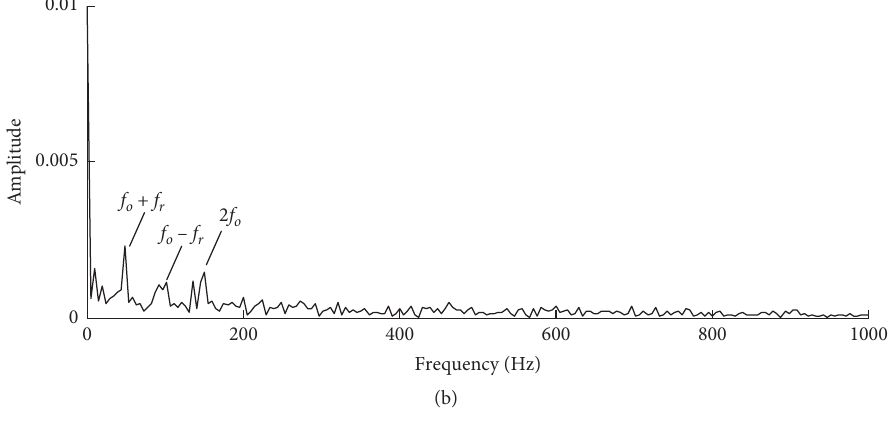
Figure 25: EEMD-TQWT decomposition result of outer race